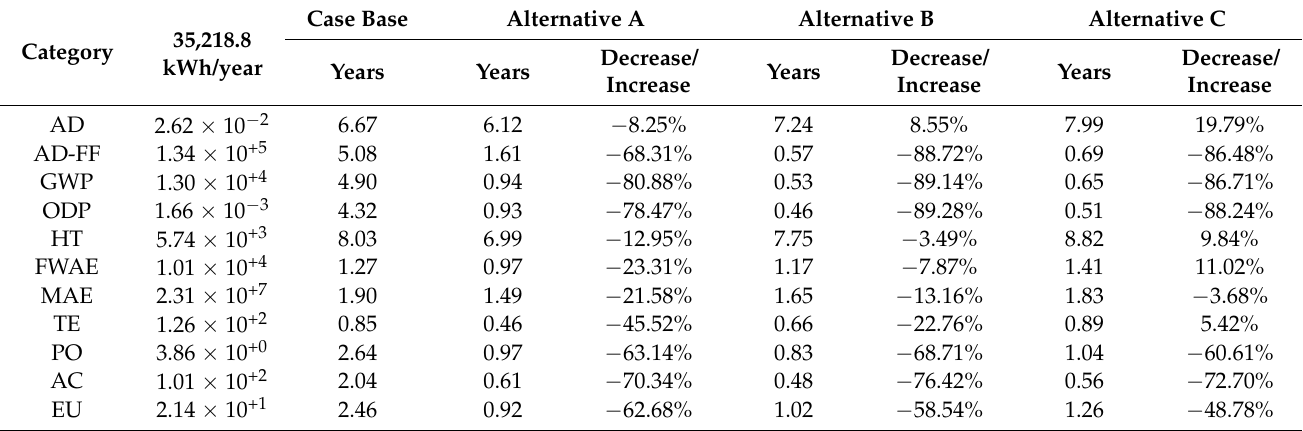
Table 8. Comparison of the amortization time of the environmental impact of the three alternatives with the base